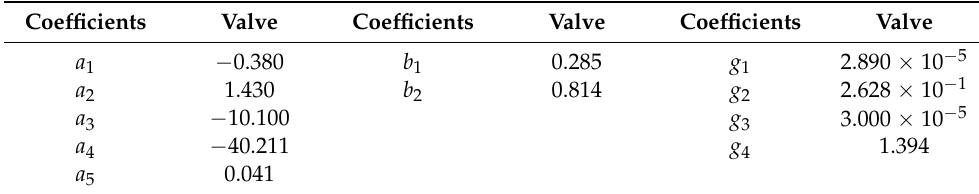
Table 2. Determined coefficients of effective force area model.